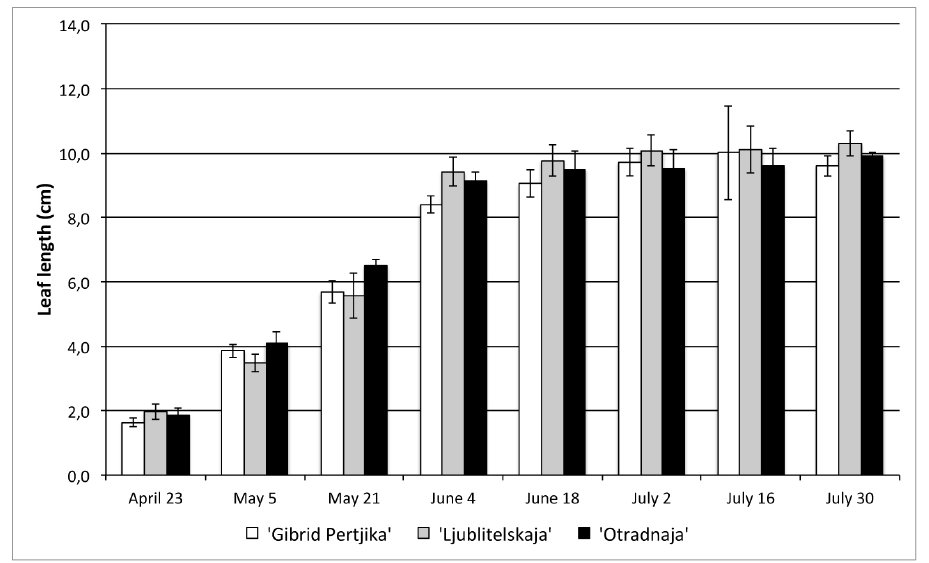
Fig. 1. Length of sea buckthorn leaves at different sampling dates for cvs. ‘Otradnaja’, ‘Gibrid Pertjika’and ‘Ljubitelskaja’. Error bars represent standard deviation